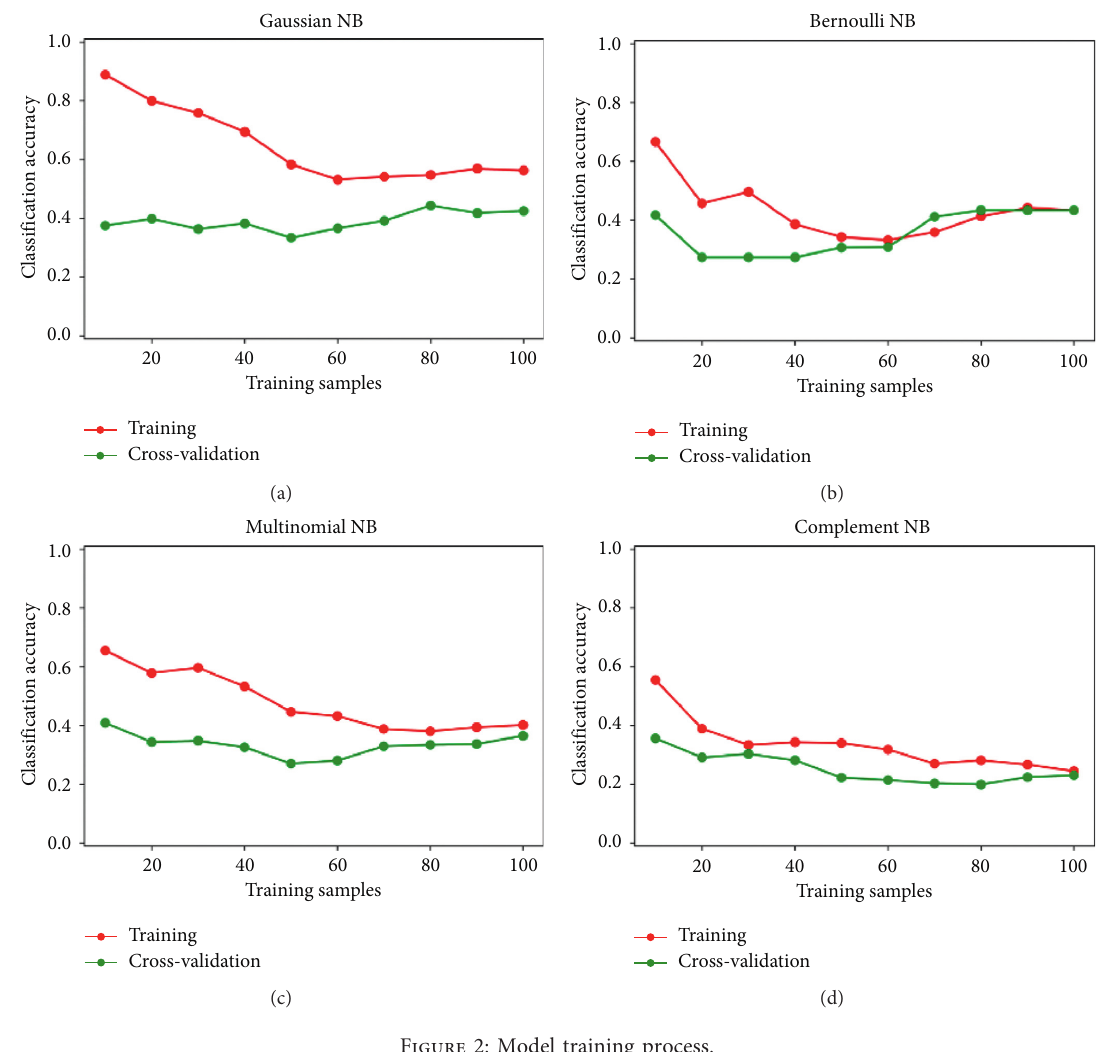
Figure 2: Model training